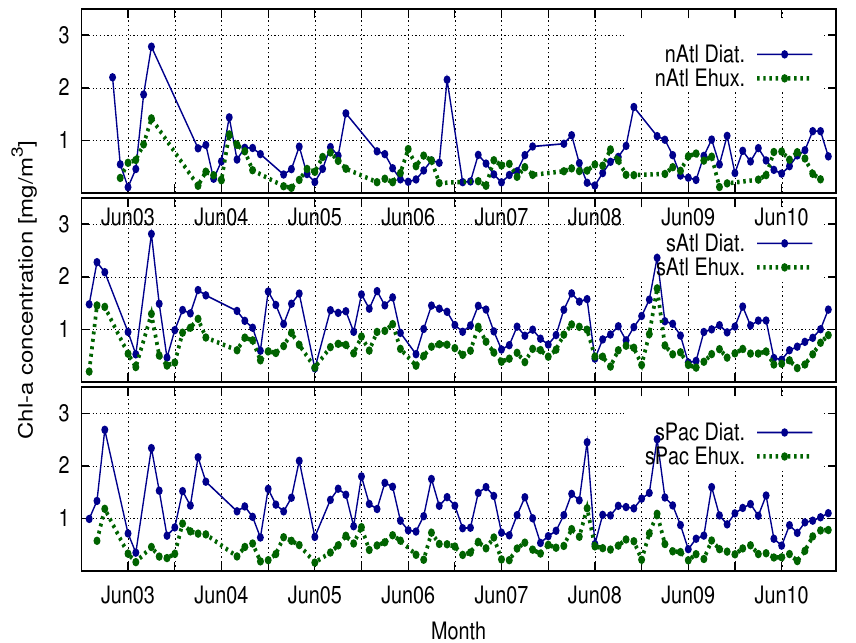
sAtl Diat. sAtl Ehux.